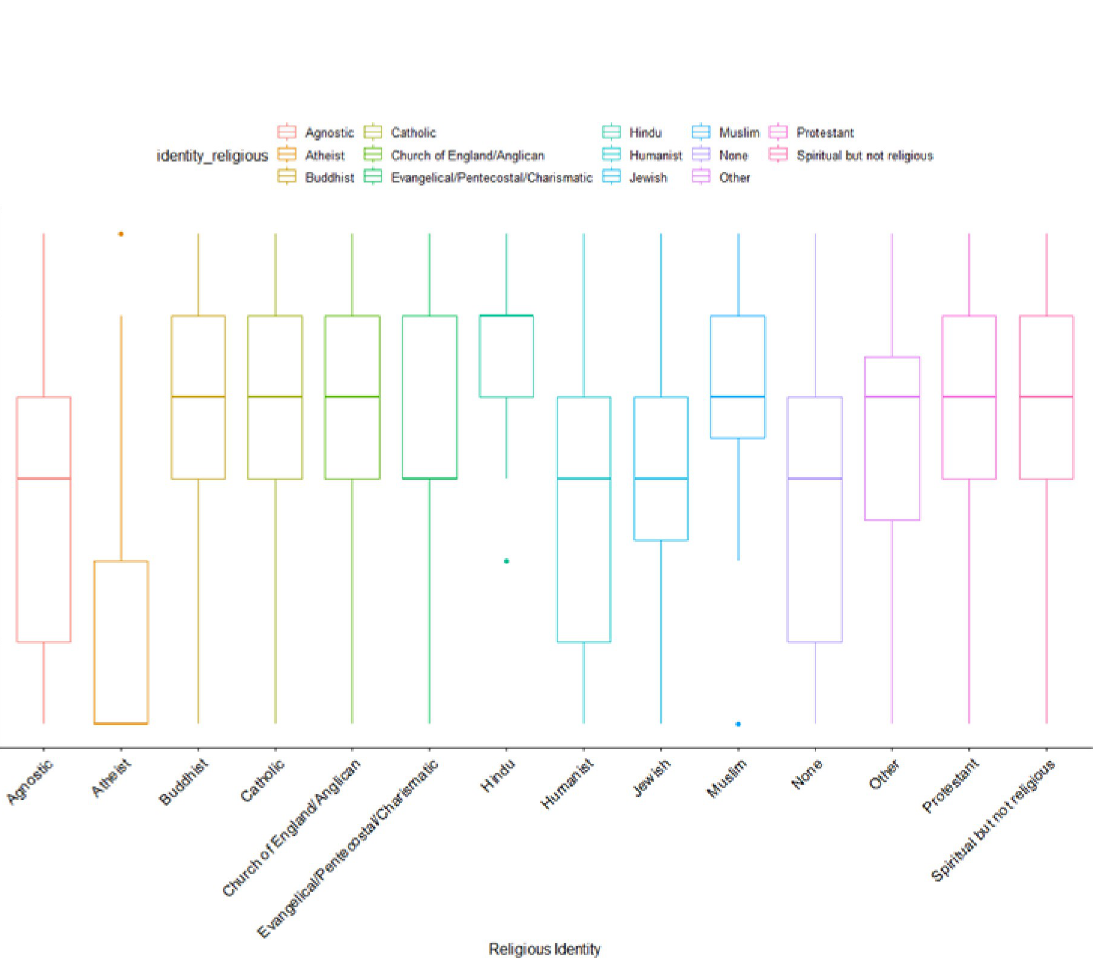
Fig 2. Strength of supernatural beliefs by religious